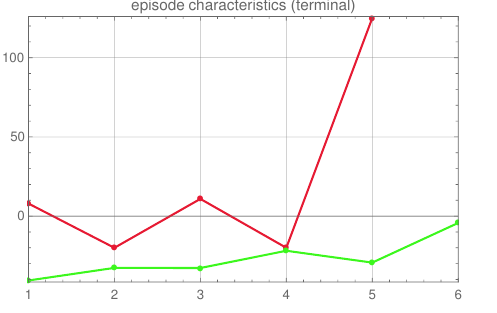
matrices Q t of the episode connecting the ini- tial state (4.8) (yellow dot) with the final state (4.7) (red dot). The labels indicate the intrinsic values. Figure 3. Characteristics of the episode connecting the states (4.8) and